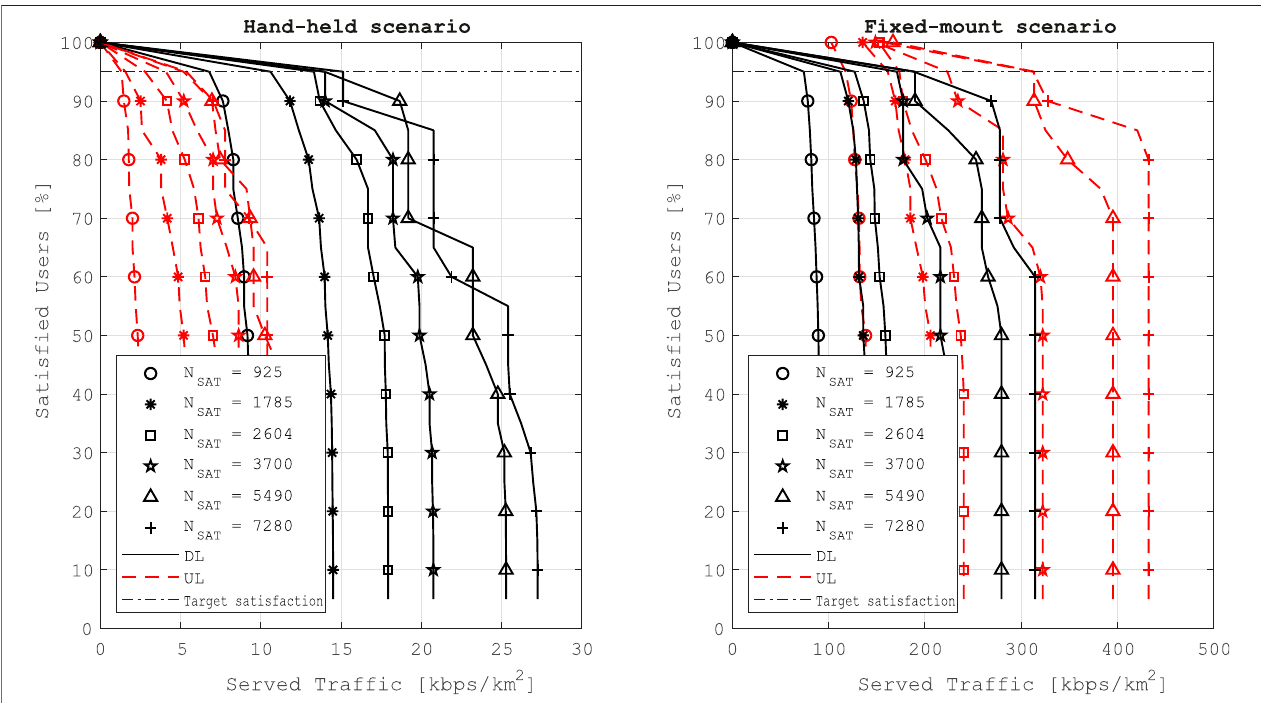
FIGURE 7 | Service coverage for NTN systems as function of served traf fi c.